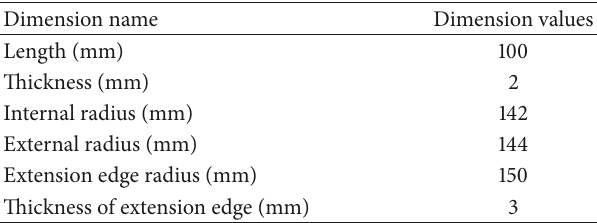
Table 1: Dimension parameters of thin cylindrical shell.